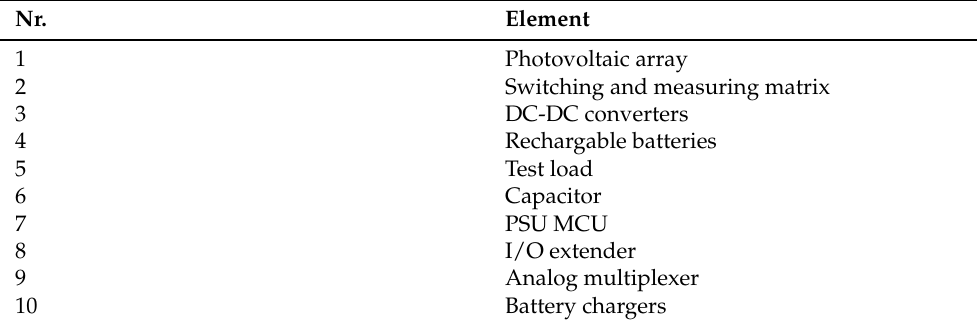
Table 1. Elements of the experimental setup.